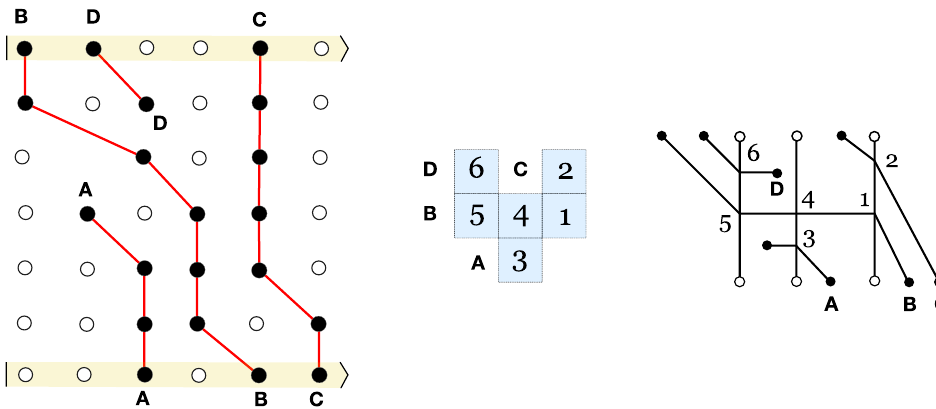
Figure 11 . A possible way of hopping of m = 4 hard magnons — labelled as A, B, C, D — with annihilation of C and injection of D , corresponding to a generalized Young diagram, i.e. to a concave fishnet on the